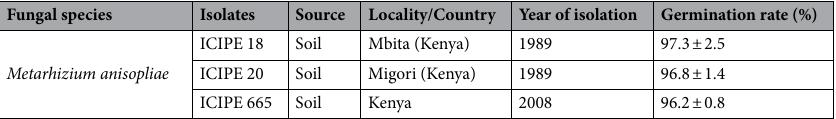
Table 4. Source and identity of the three Metarhizium anisopliae isolates used in the study and their germination